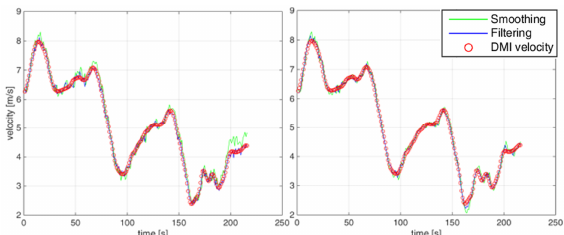
Figure 12. On the left the UKF augmented and on the right the not-augmented tangential velocities with 6 states Figure 12 and the previous Figure 10 show results of tangential